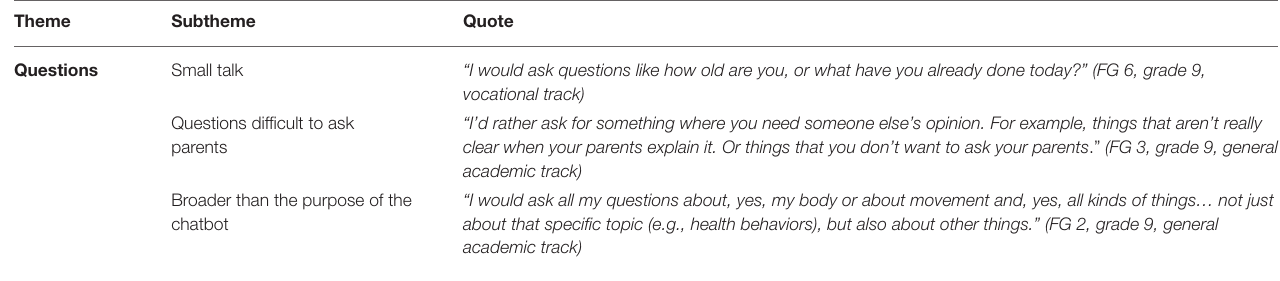
TABLE 2 | Results from the focus groups regarding questions adolescents would